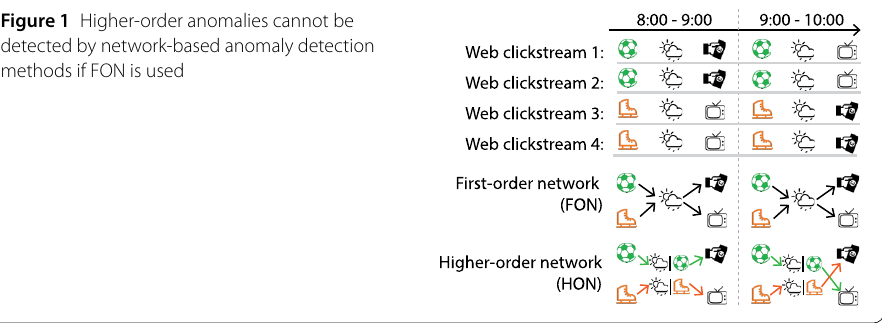
Figure 1 Higher-order anomalies cannot be detected by network-based anomaly detection methods if FON is